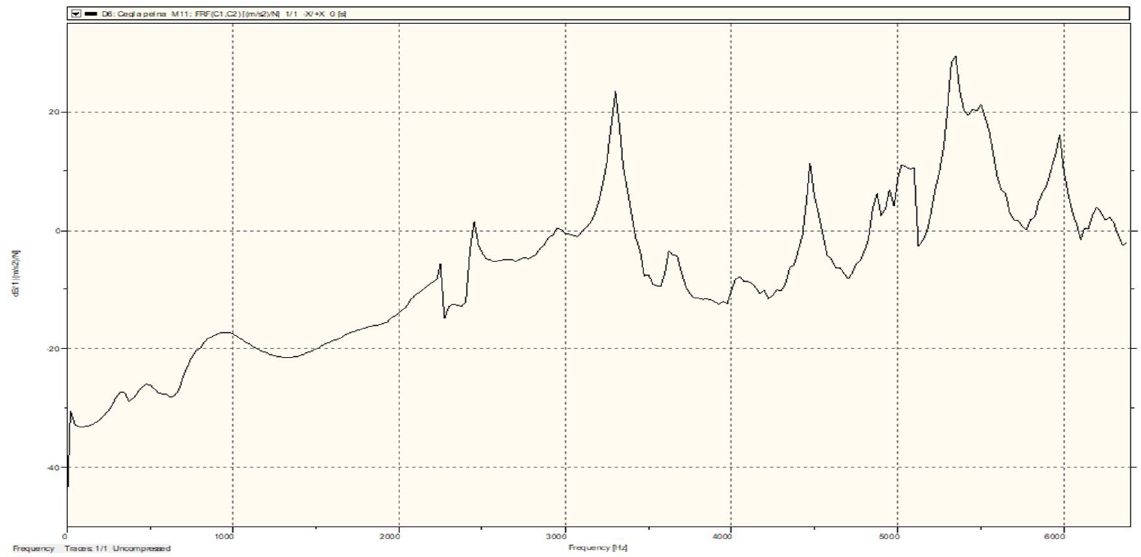
Figure 6. Spectral function of the FRF transition registered at point